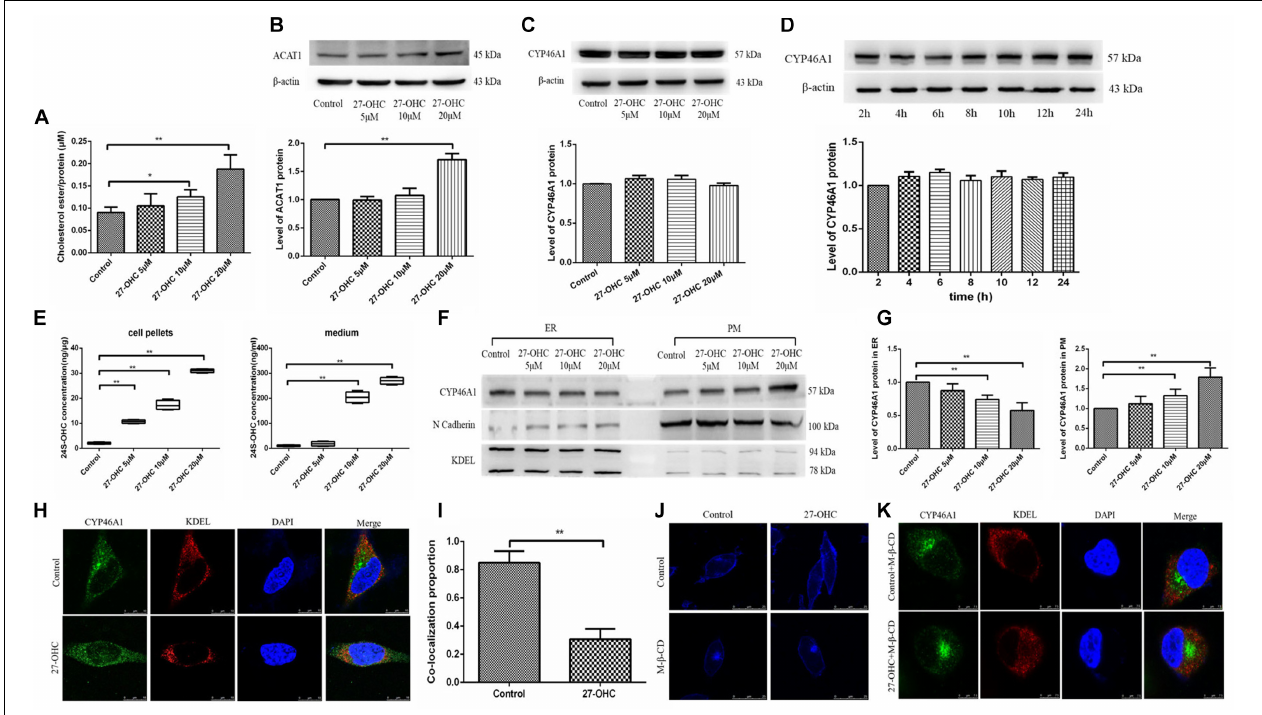
FIGURE 5 | Assessment of cholesterol storage and clearance in SH-SY5Y cells. (A) Cholesterol ester levels in SH-SY5Y cells after 0, 5, 10, and 20 µ M 27-OHC treatment for 24 h. (B) Western blot analysis of ACAT1 in SH-SY5Y cells after 0, 5, 10, and 20 µ M 27-OHC treatment for 24 h. (C) Western blot analysis of total CYP46A1 in SH-SY5Y cells after 0, 5, 10, and 20 µ M 27-OHC treatment for 24 h. (D) Western blot analysis of total CYP46A1 in SH-SY5Y cells after 20 µ M 27-OHC treatment for 2, 4, 6, 8, 10, 12, and 24 h, respectively. (E) 24S-OHC content in SH-SY5Y cell pellets and medium after various concentrations of 27-OHC treatment for 24 h. (F,G) The protein level of CYP46A1 in endoplasmic reticulum (ER) and plasma membrane (PM) in SH-SY5Y cells after 0, 5, 10, and 20 µ M 27-OHC treatment for 24 h. N cadherin and KDEL were used as PM and ER markers, respectively. (H) Immunofluorescence staining for CYP46A1 (green) and KDEL (red) confirmed that 27-OHC induced CYP46A1 translocation in SH-SY5Y cells. DAPI (blue) represented the nucleus (scale bar: 10 µ m). (I) Colocalization analysis of CYP46A1 and KDEL. (J) Membrane cholesterol observation of SH-SY5Y cells in different groups. Compared with the control group, membrane cholesterol accumulation was elevated in the 20 µ M 27-OHC group. 10 mM M- β -CD significantly reduced the membrane cholesterol in SH-SY5Y cells with or without 27-OHC intervention. Filipin III staining to visualize cholesterol under a confocal microscope (scale bar: 25 µ m). (K) Immunofluorescence staining for CYP46A1 (green) and KDEL (red) confirmed that 27-OHC induced CYP46A1 translocation in SH-SY5Y cells. DAPI (blue) represented the nucleus (scale bar: 7.5 µ m). * P < 0.05 compared with the control group; ** P < 0.01 compared with the control group (one-way